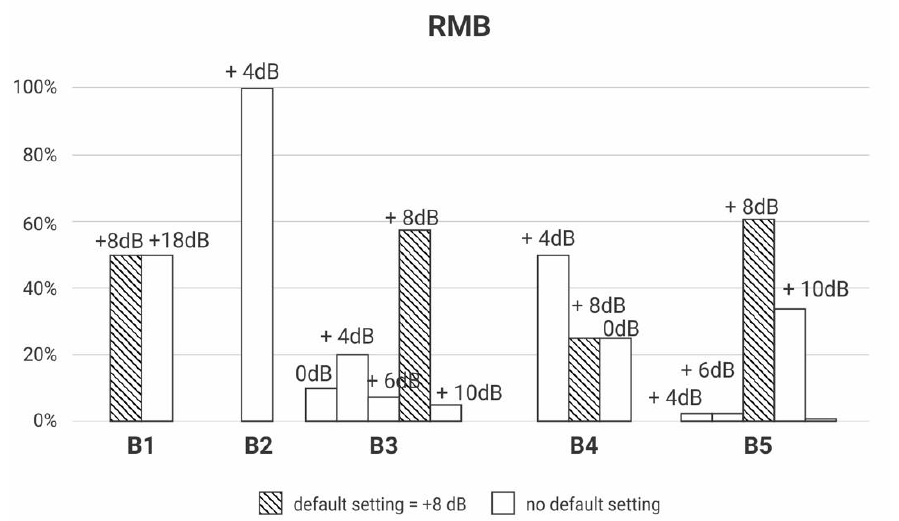
Figure 3. Descriptive analysis of RMA’s receivers’ (A1, A2, A3, A4) gain setting to achieve transpar- ency ( n = 80).